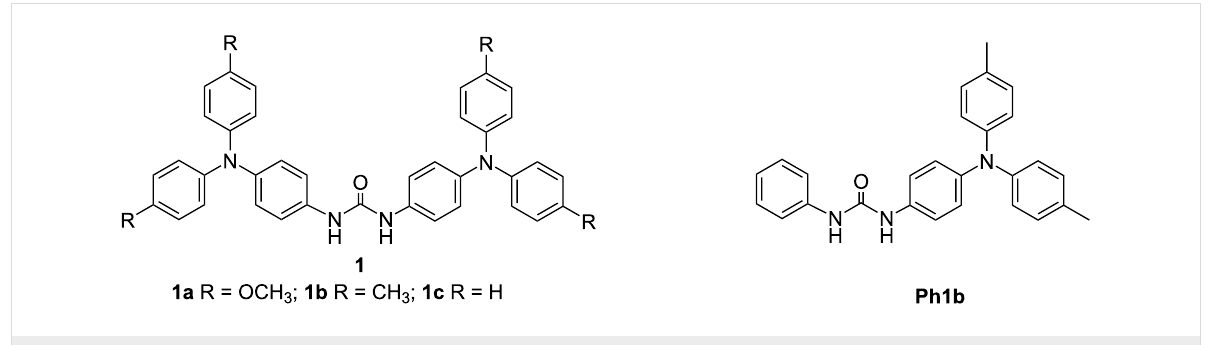
Figure 1: Structures of target compounds 1 and reference compound Ph1b